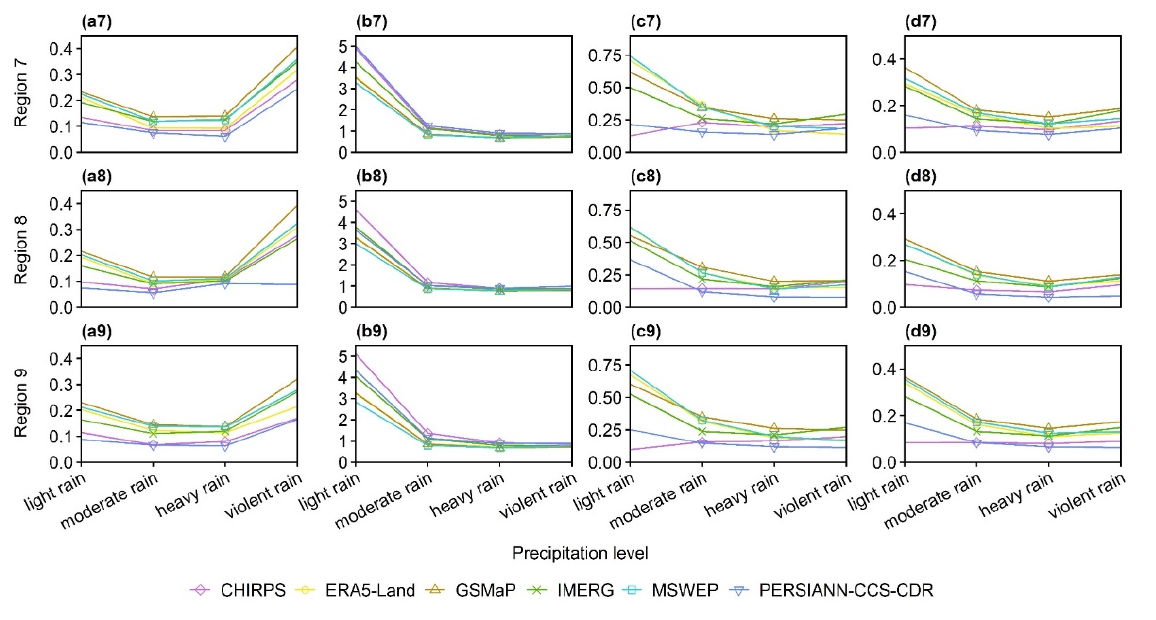
Figure 7. Mean values of four statistical metrics of precipitation products at four precipitation levels in different regions between 2015 and 2019. From left to right: ( a1 – a9 ) CC, ( b1 – b9 ) RRMSE, ( c1 – c9 ) POD and ( d1 – d9 ) CSI. Violent rain is not counted in R 2 and R 5 due to the low frequency of events.